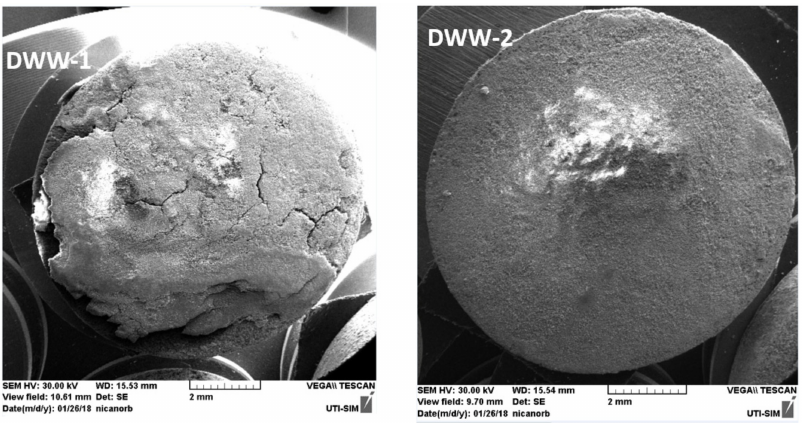
Figure 23. SEM Images of samples after immersion for 90 days in DWW-1 and DWW-2. The surface aspect after drying the immersed samples at higher magnification is shown in Figure 24.